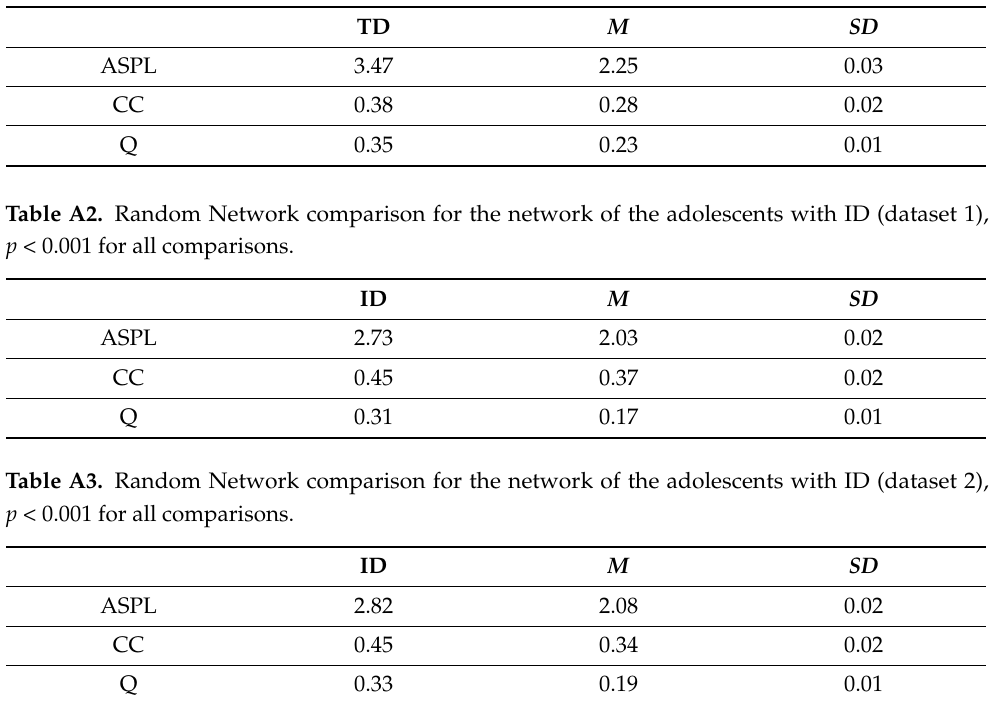
Table A1. Random Network comparison for the network of the children with TD, p < 0.001 for all comparisons.